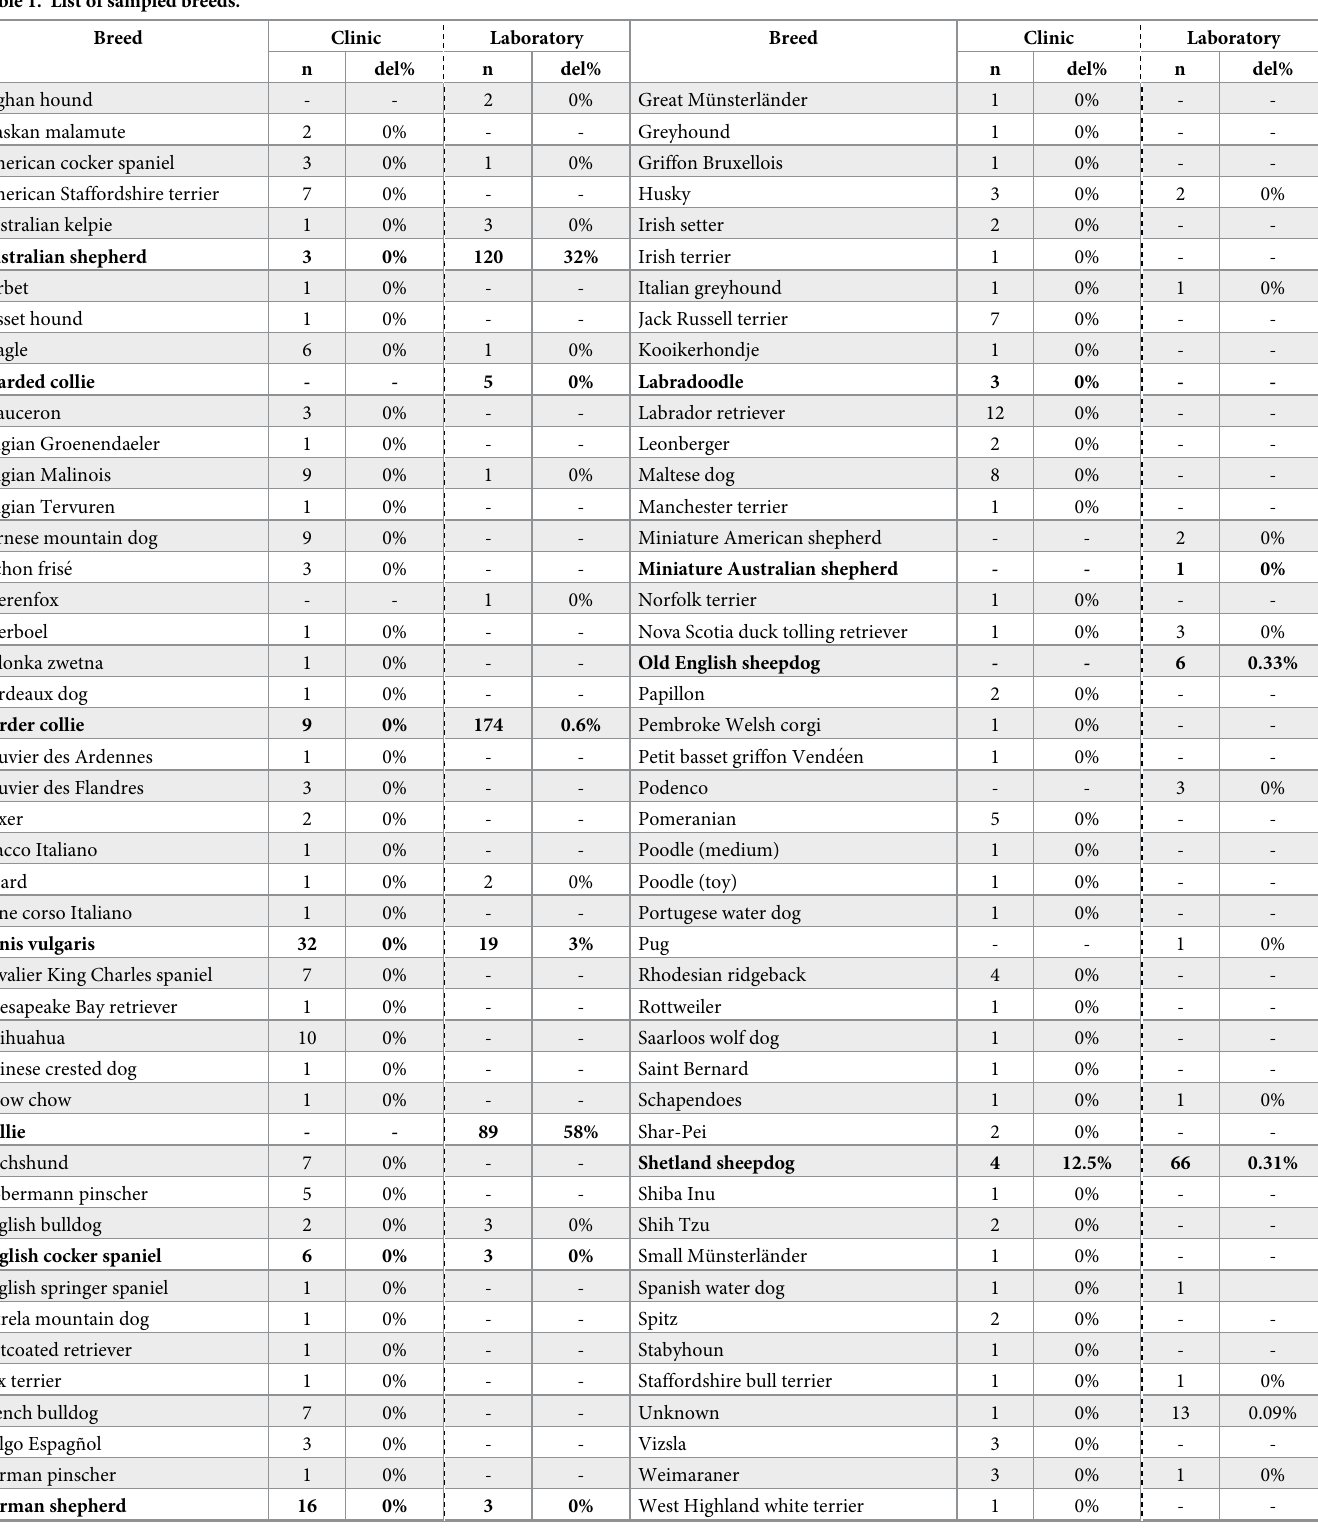
Table 1. List of sampled breeds. Breed